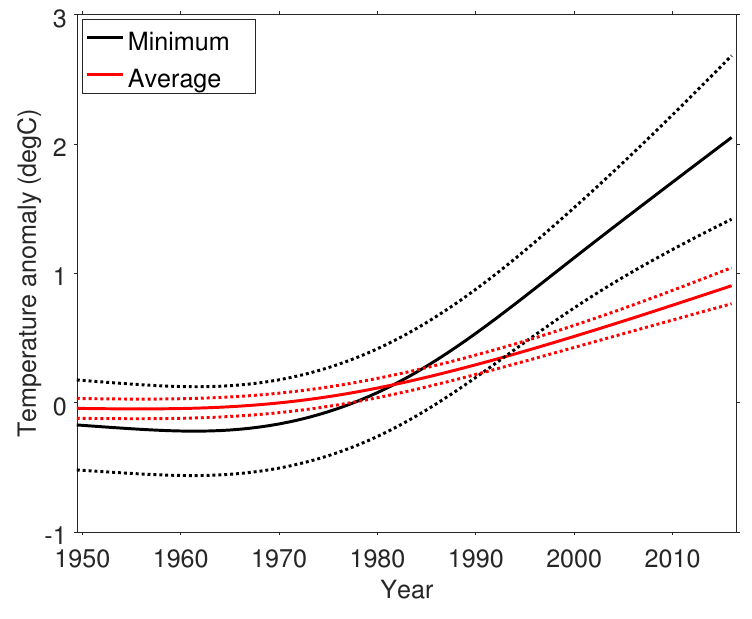
Figure 2. Smoothed global mean anomalies (over stations) in annual mean and annual minimum temperatures (1950–2016), expressed relative to the 1900 smoothed value. The dashed lines show 95% confidence intervals of the smoothed